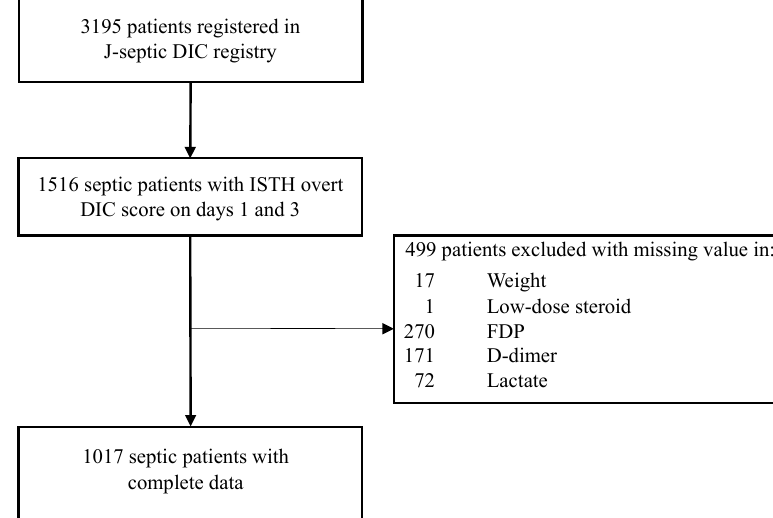
Figure 1. Schematic for patient screening, enrolment, and analysis. DIC, disseminated intravascular coagulation; ISTH overt DIC score, International Society on Thrombosis and Haemostasis overt Disseminate Intravascular Coagulation score; FDP, fibrin/fibrinogen-degradation product.